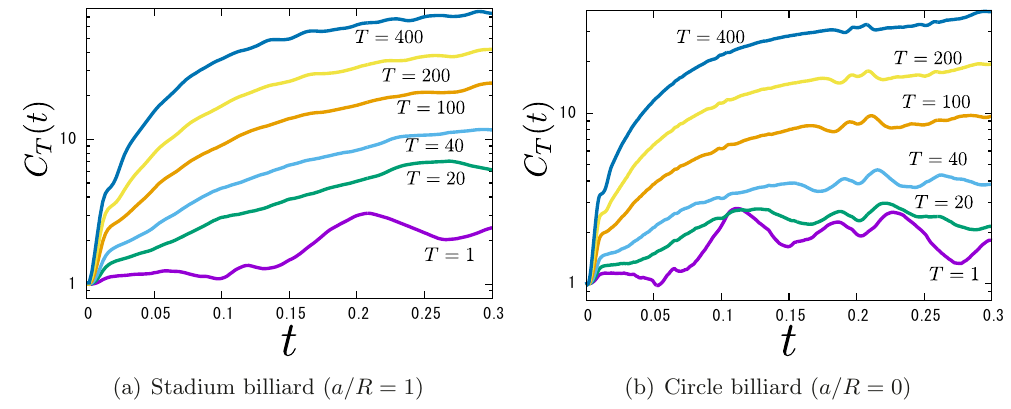
Figure 8 . Early time evolution of thermal OTOCs for the stadium ( a/R = 1) and circle ( a/R = 0)